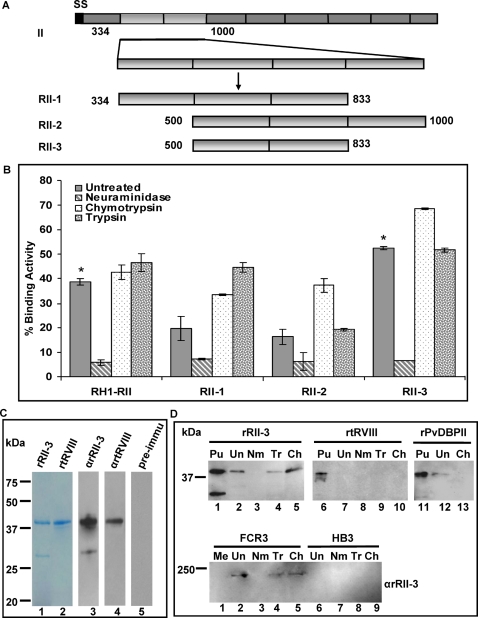
Erythrocyte-binding assay on transfected COS7 cells expressing region II deletion constructs and purified recombinant proteins rRII-3 and rtRVIII.(A) Overall architecture of Region II deletion constructs of PfRH1. RII-1 contains region II amino acids from 334 to 833. RII-2 consists of region II amino acids from 500 to 1000. RII-3 contains region II amino acids from 500 to 833 (light gray). (B) Comparison of erythrocyte-binding assay with full-length RII and deletion constructs before and after enzymatic treatment. Rosettes were scored in 30 fields at 200× magnification. Data are present as percentage of binding activity (%) after the number of observed rosettes was normalized for 5% transfection efficiency in three independent experiments, and the error bar denotes the SE. * p<0.001, indicating that after neuraminidase-treatment, the binding of RII and RII-3 was significantly decreased compared to untreated erythrocytes. (C) Purified rRII-3 and rtRVIII were shown in coomassie blue staining (lane 1 and 2) and detected by western blot with αrRII-3, αrtRVIII and pre-immune serum respectively (lane 3 to 5). (D) Purified rRII-3, rtRVIII as well as rPvDBPII bound to erythrocytes was detected by Western blot with anti-His antibody (top). The experiments were carried out from a single batch of purified proteins and run on the same blot. Purified (Pu) rRII-3, rtRVIII and rPvDBPII (Lane 1, 6 and 11). Untreated human erythrocytes (Un) (Lane 2, 7 and 12). Neuraminidase-treated human erythrocytes (Nm) (Lane 3 and 8). Trypsin-treated human erythrocytes (Tr) (Lane 4 and 9).Chymotrypsin-treated human erythrocytes (Ch) (Lane 5, 10 and 13). Enriched culture supernatant from FCR3 and HB3 bound to erythrocytes was also detected by western blot with αrRII-3 (bottom). Culture medium alone (Me) was used as a negative control. The rest of the labels from bottom panel are the same as metioned above. Purified rPvDBPII and culture supernatant were used as positive control to determine the specific binding of the rRII-3. Molecular sizes are indicated on the left (in kDa).